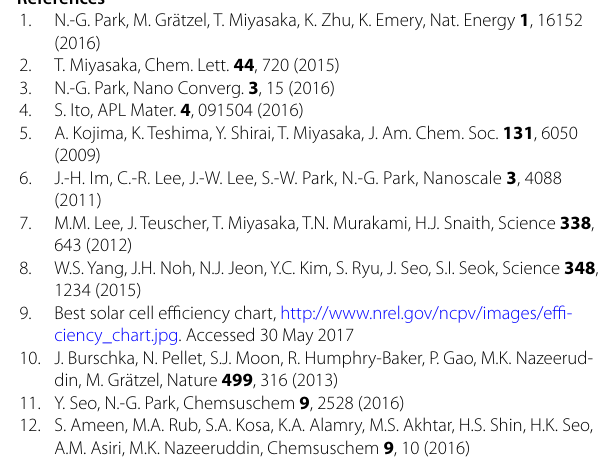
Fig. 5 Photographs of the perovskite solar cells; a the fresh and b under the N 2 glove box for 24 h. On the left side ; the solar cells were fabricated using non‑aqueous process synthesis method prepared ZnO nanoparticles (No. 1). On the right side ; the solar cells were fabricated using aqueous process synthesis method prepared